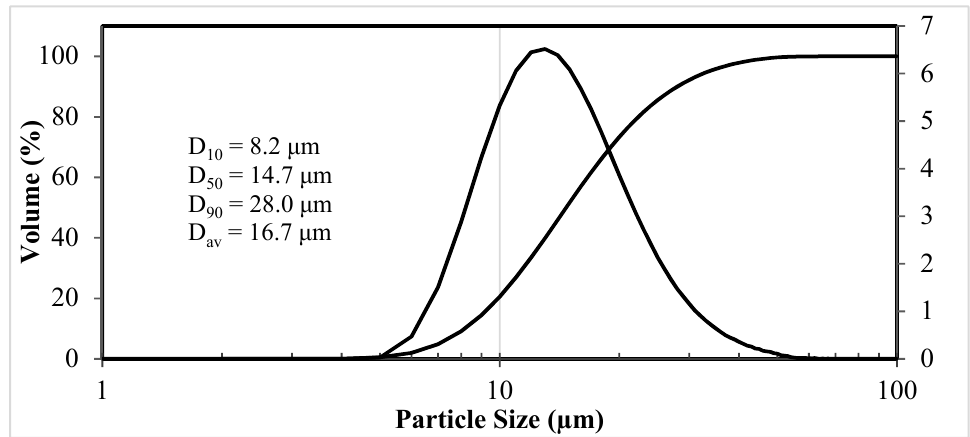
Figure 7. Differential and integral particle size distribution of W-C-Co micropowder after treatment in plasma and removal of nano- and submicron particles. Table 1. Characteristics of W-C-Co powders